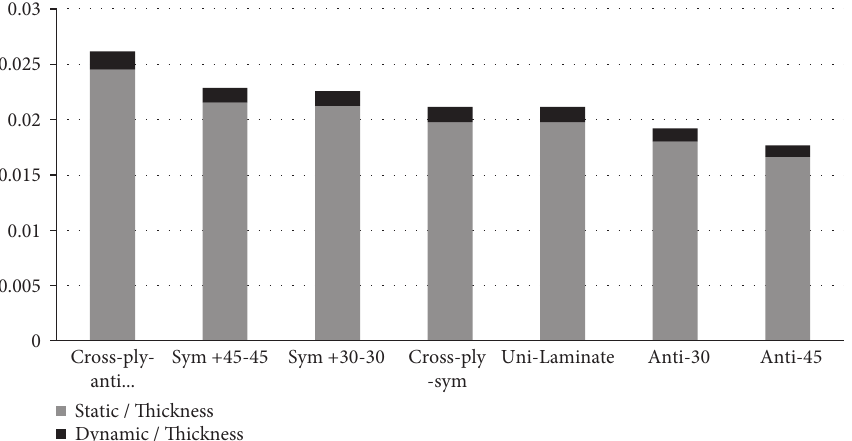
Figure 1: Presentation of the static amplitude of the laminate response shown in pattern fill and the maximum dynamic amplitude shown in black solid color.